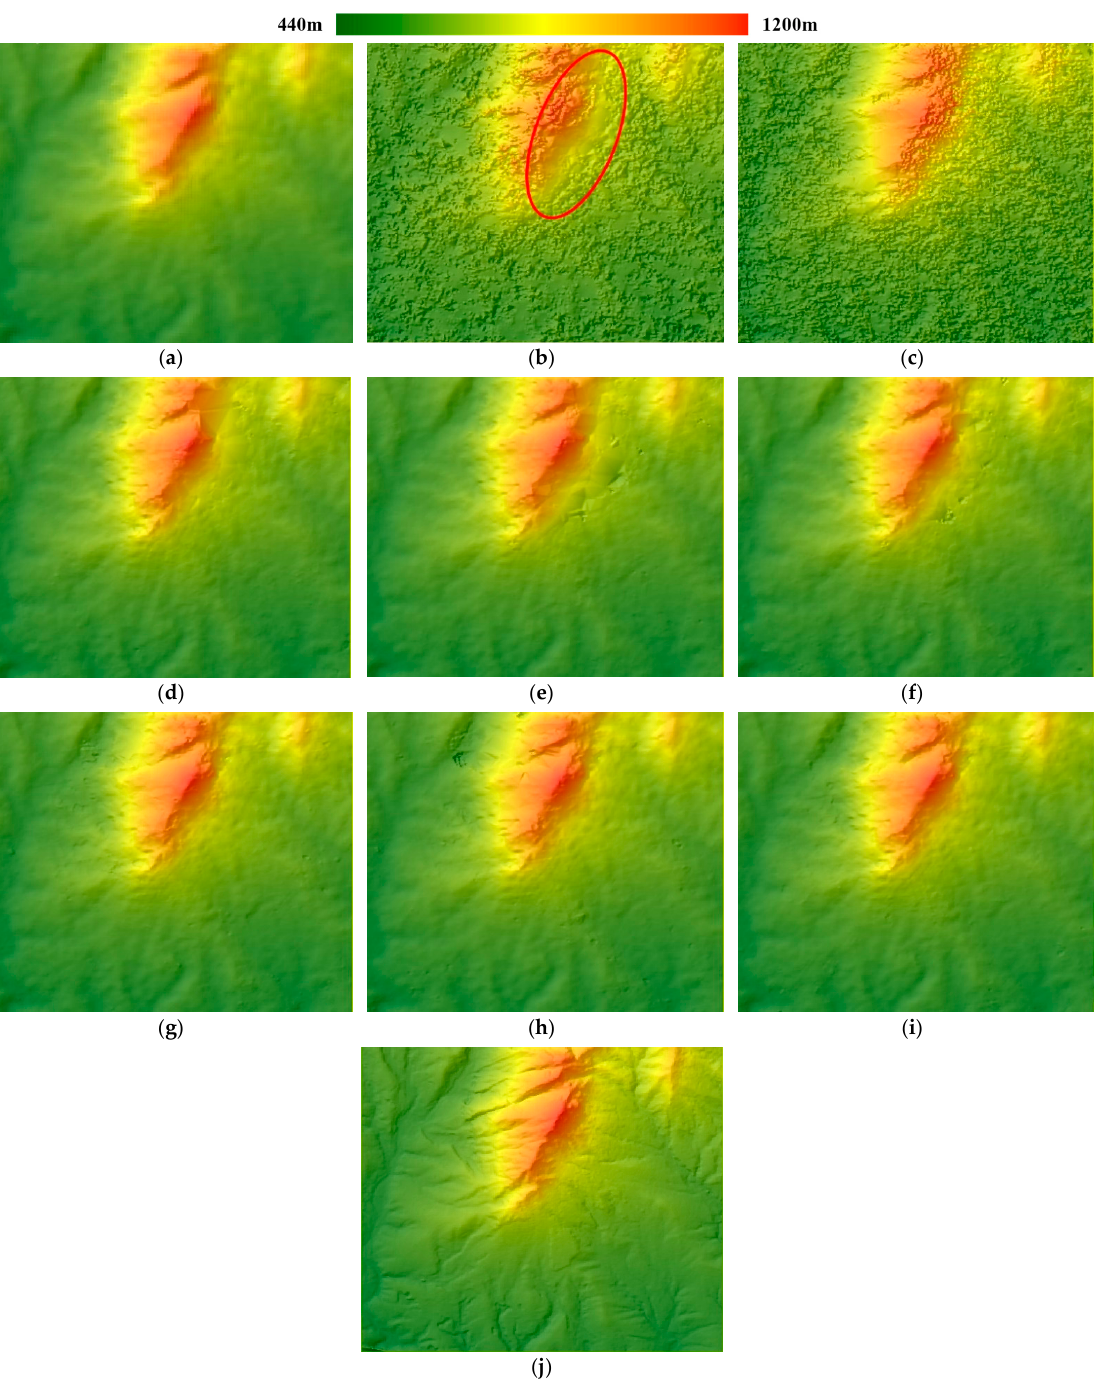
Figure 8. Hillshade of test area 2: ( a – c ) Hillshade of SRTM DEM, SL mode DSM by NCC, and SM mode DSM by NCC; ( d – f ) Hillshade of SL mode DSMs by SGM_const, SGM_gray, and SGM_canny;